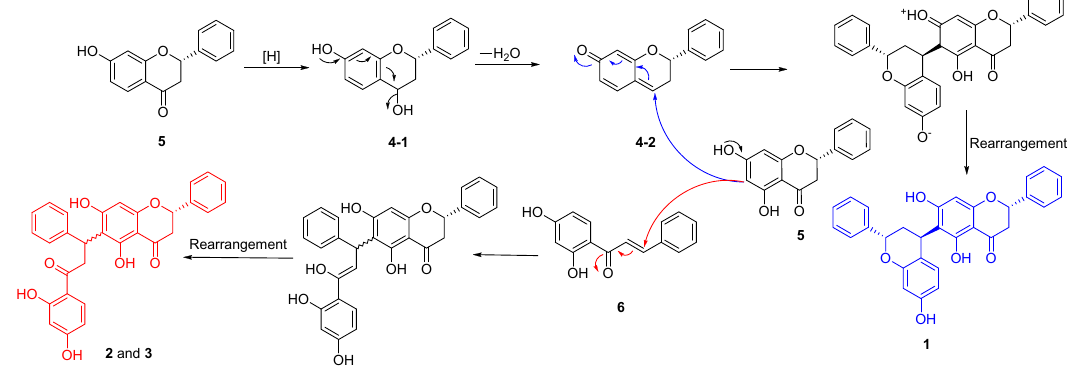
Figure 3. ECD spectra of compounds 1 – 3 . Table 2. 1 H-NMR (500 MHz) and 13 C-NMR (125 MHz) data for oxytrochalcoflavanones A ( 2 ) and B ( 3 ) ( δ in ppm, J in Hz, in CDCl 3 ).